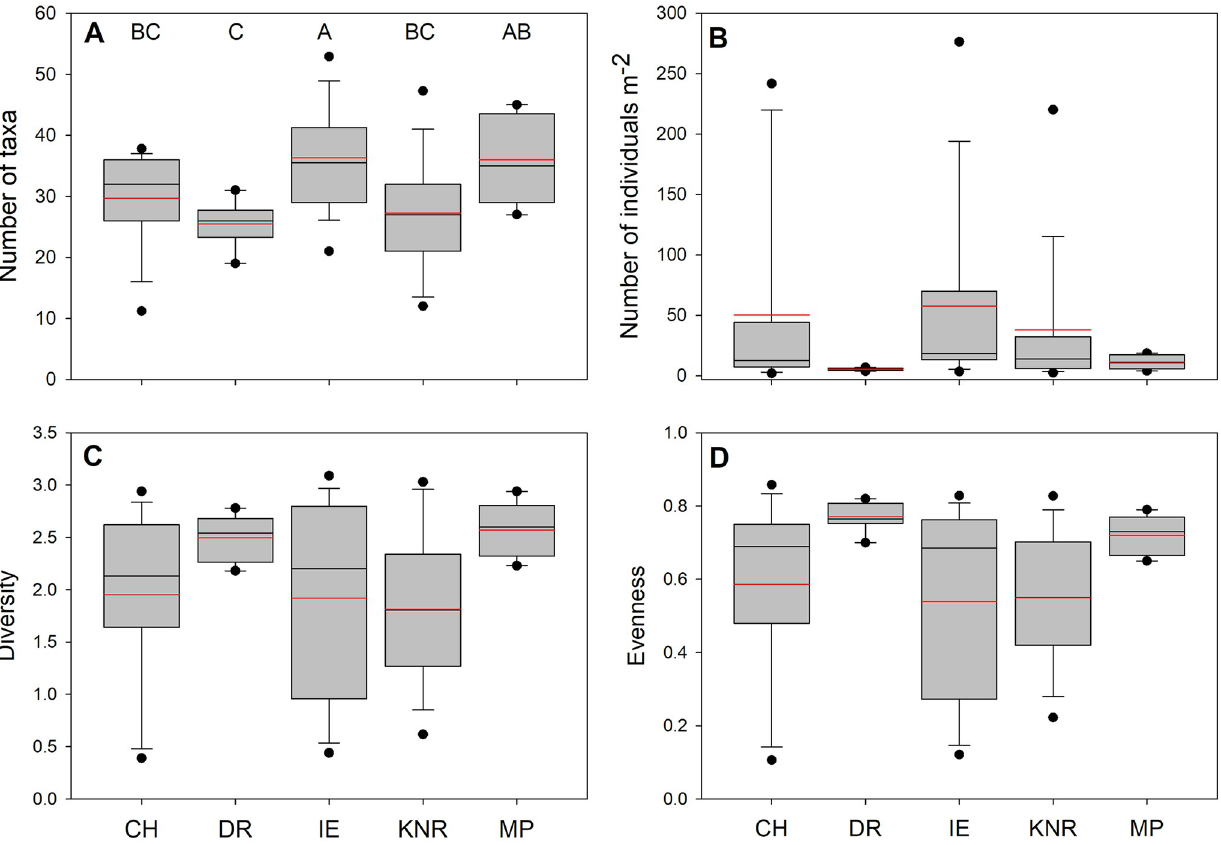
Fig 3. Comparisons of kelp forest community metrics among regions. A. Taxa richness, B. Numerical abundance (Num. individuals m -2 ), C. Shannon- Wiener Diversity, D. Pielou’s Evenness. Boxes represent 25th, median, and 75th percentiles, and upper and lower quartiles. Black horizontal lines are median and red horizontal lines are mean values. Regions with the same letter are not significantly different ( α = 0.05). Results of Generalized Linear Models with Poisson distributions and log-link functions and pair-wise contrasts using -Loglikelihood